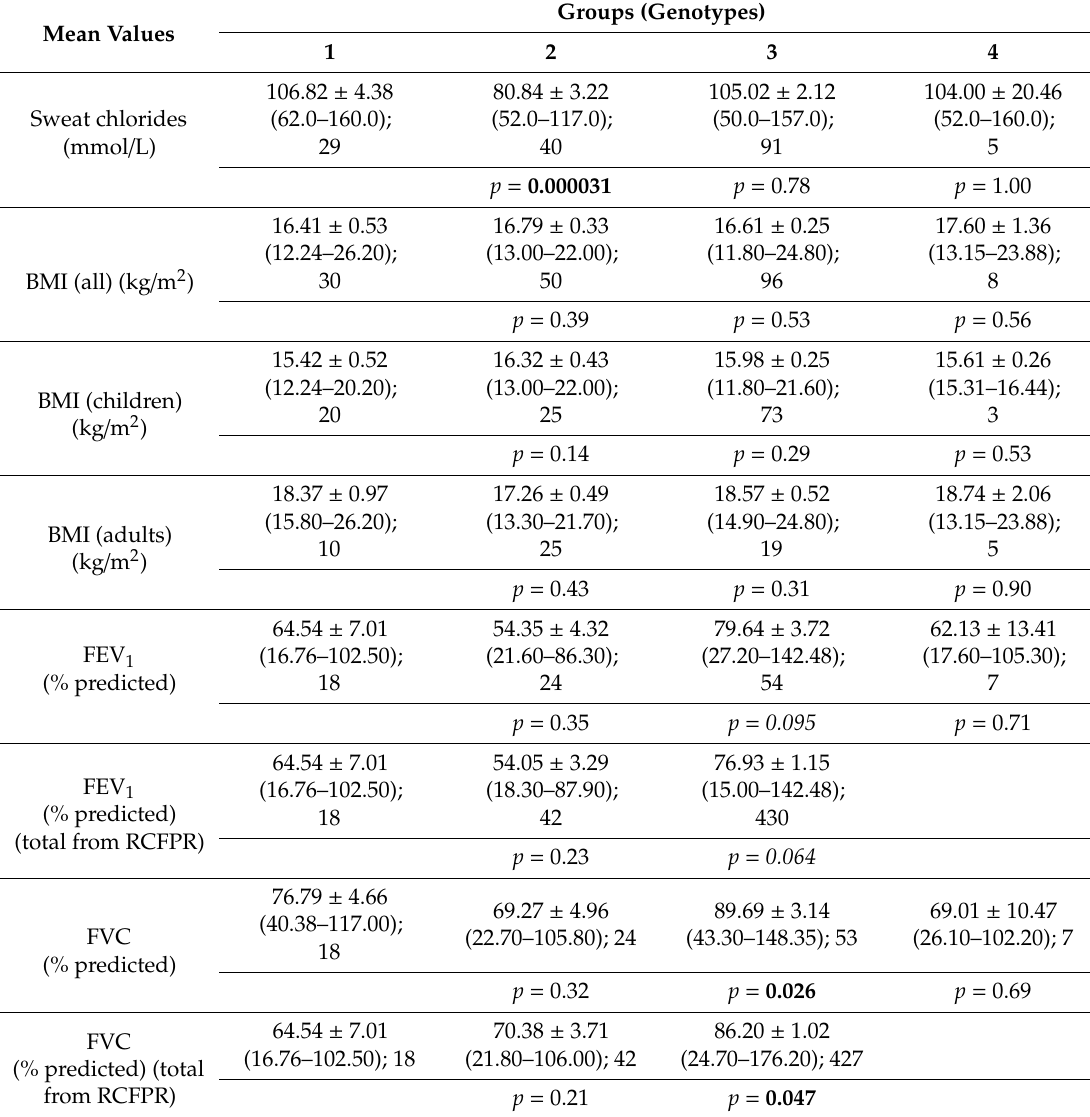
Table 3. Mean values of clinical and functional characteristics in CF patients with various genotypes. Mean